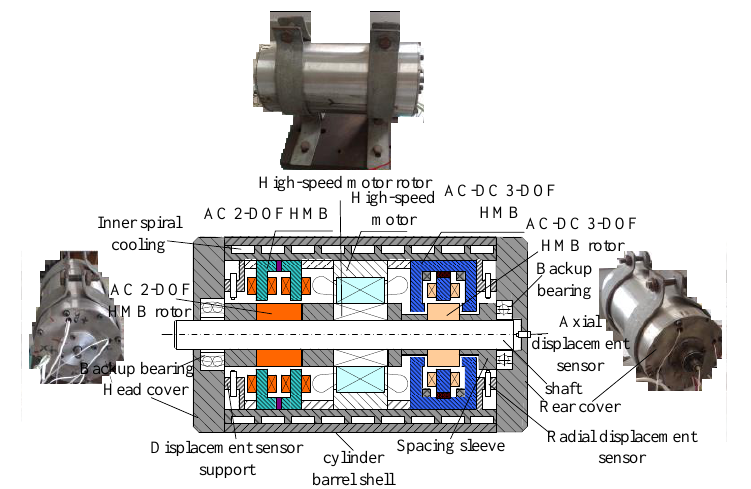
Figure 1. Prototype of the five-degrees-of-freedom (5-DOF) AC hybrid magnetic bearings (HMB)-supported motorized spindle.